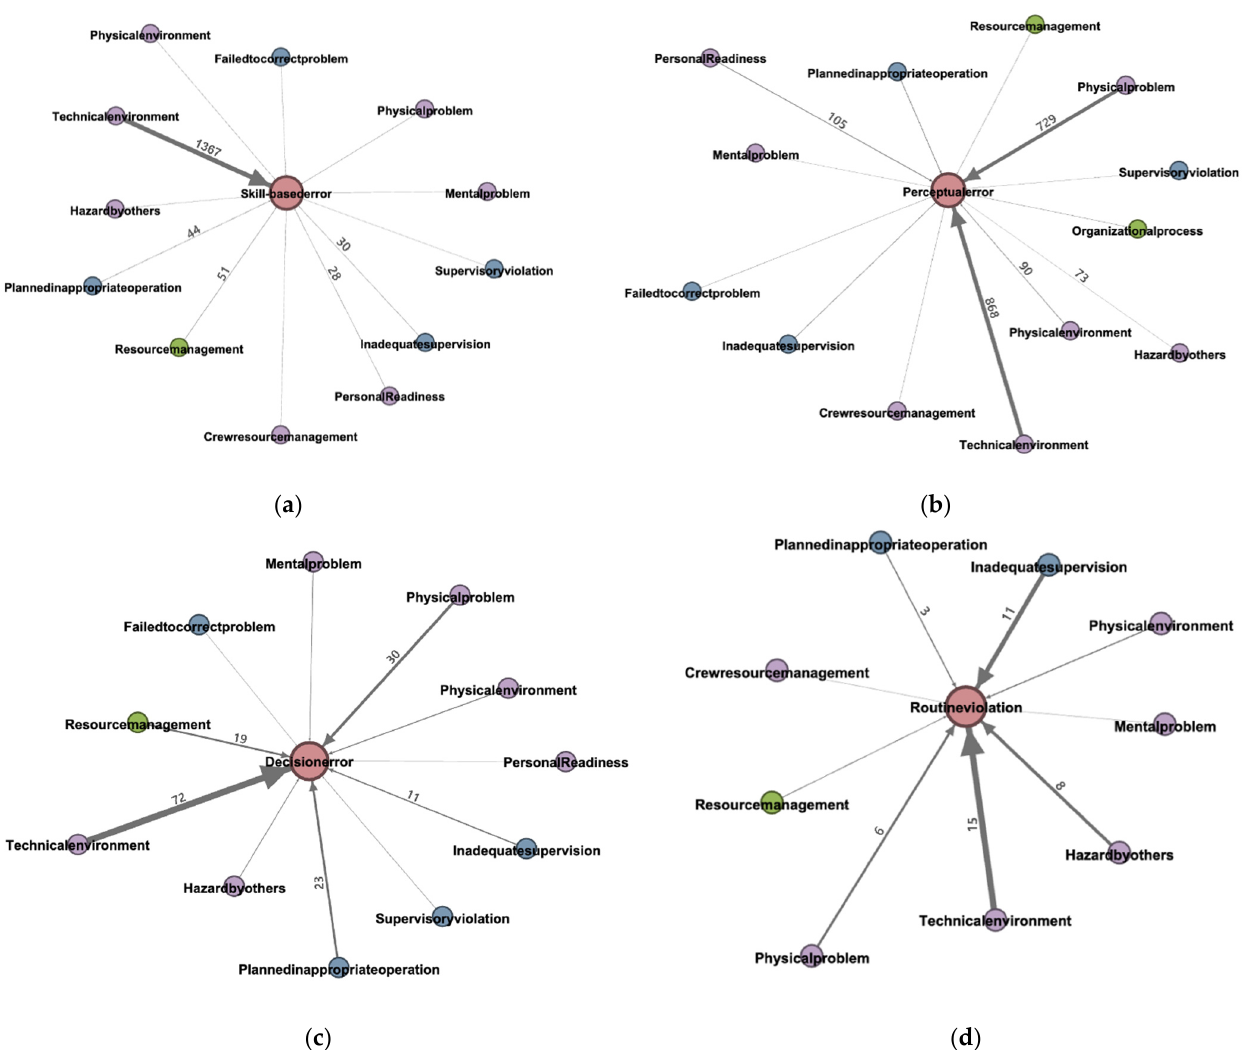
Figure 5. Network diagrams of unsafe act factor analysis results: ( a ) skill-based errors (SBEs) network diagram; ( b ) perceptual errors (PERs) network diagram; ( c ) decision errors (DEs) network diagram; ( d ) routine violations (RVs) network diagram.